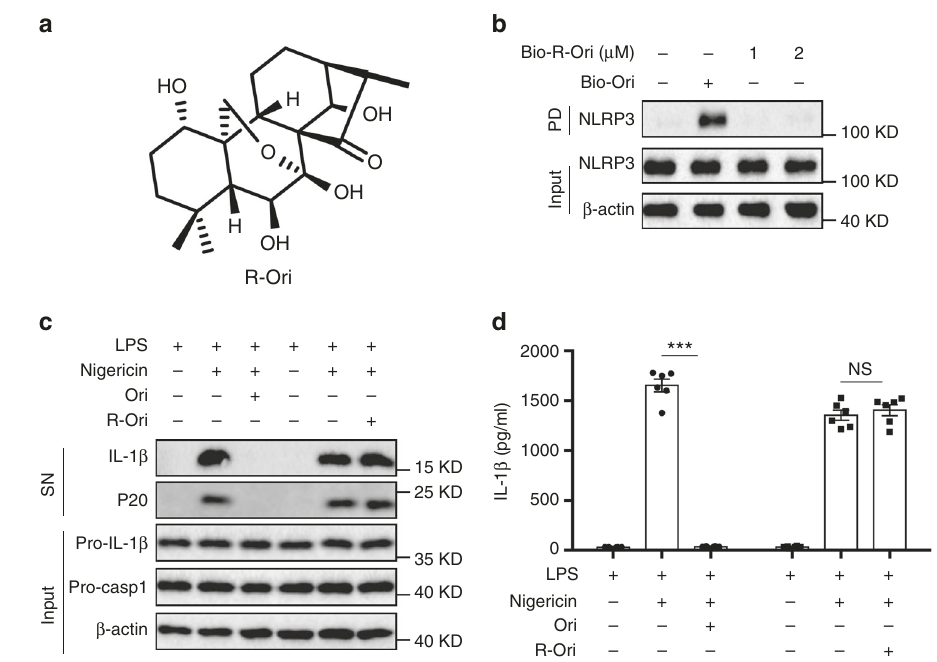
Fig. 5 Ori binds to NLRP3 via its active carbon – carbon double-bond. a Structure of Ori without carbon – carbon double-bond (R-Ori). b Cell lysates of LPS- primed BMDMs were incubated with bio-Ori (1 μ M) or indicated doses of bio-R-Ori for 2 h, and then pulled down using streptavidin beads. c , d Western blot analysis ( c ) of cleaved IL-1 β and activated caspase-1 or ELISA of IL-1 β ( d ) in SN from LPS-primed BMDMs pretreated with Ori (2 μ M) or R-Ori (2 μ M) for 0.5 h and then stimulated with nigericin. Data are expressed as mean and s.e.m ( n = 6) from three independent experiments ( d ) or are representative of three independent experiments ( b , c ). Statistical differences were calculated by unpaired Student ’ s t -test: *** P <